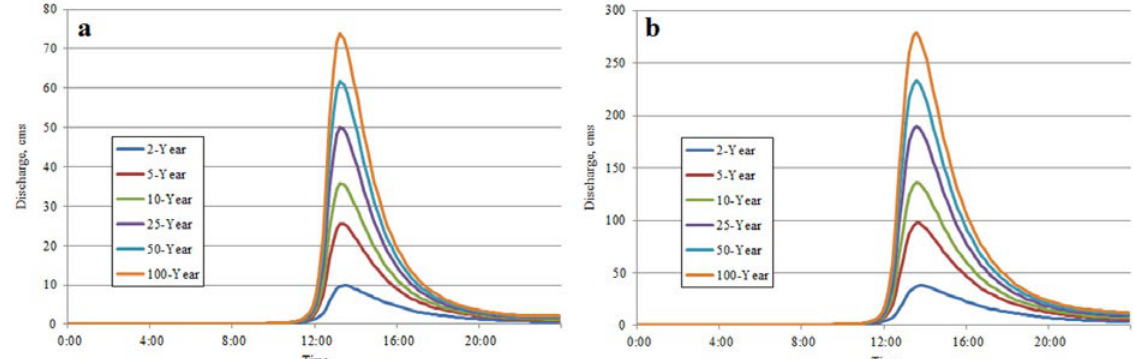
Fig. 7: Simulated hydrographs using the calibrated HEC HMS model of Malingon river and rainfall scenarios (a: J467 and b: J530)